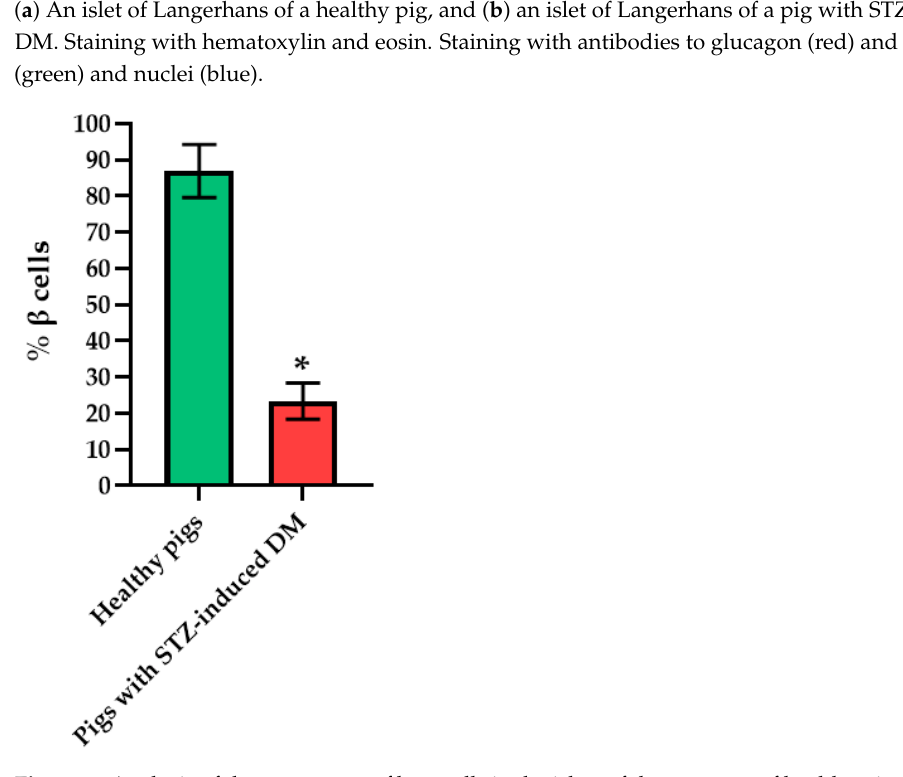
Figure 6. Analysis of the percentage of beta cells in the islets of the pancreas of healthy pig compared with a pig with STZ-induced DM. *— p = 0.00000.